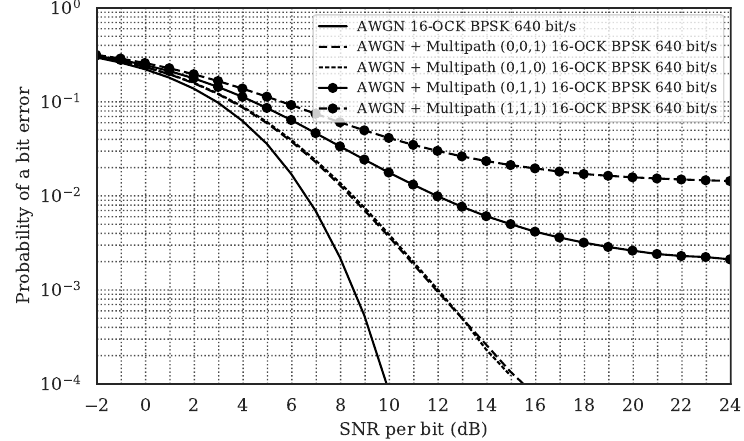
Figure 5. Simulated BER vs. (cid:101) b / N 0 for 16-OCK BPSK in AWGN + multipath channels. Multipath configurations: (A,B,C), where position A = 2, B = 34, C = 67 chips delay. The value indicates relative amplitude compared to the direct path.